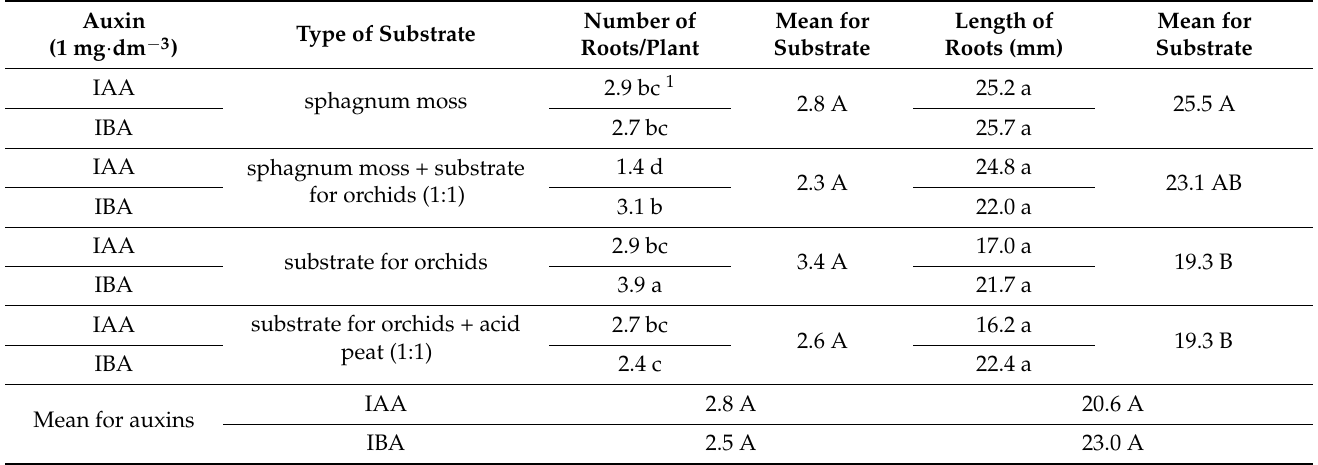
Table 5. A subsequent effect of IAA or IBA and substrate type on the rooting of P. insigne during acclimatization. Auxin (1 mg · dm − 3